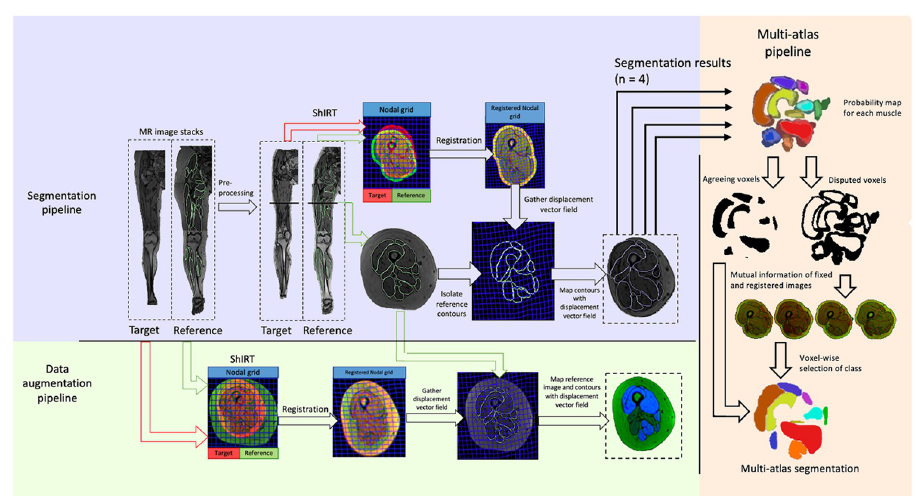
Fig 2. Registration, multi-atlas, and image augmentation pipelines. The image registration process, shown for one 2D slice of imaging data (location within imaging sequences highlighted with a black line). Segmentation pipeline: the target and reference subject were pre-processed, homogenizing the fat layer, and registered in ShIRT. The map found through registration was applied to the manual segmentation contours of the reference subject (shown in green), resulting in an automatic segmentation of the target subject (shown in blue). Data augmentation pipeline: The combined MR imaging sequences are registered in ShIRT. The map outputted from the registration was used to deform the reference subject’s 3D imaging data and reference manual segmentations, resulting in a fully segmented, augmented 3D image. The augmented images are shown with each muscle taking a different greyscale value (visualised in blue image channel). The multi-atlas pipeline used is also shown on the right-hand side. The outputs of the segmentation pipeline are combined forming a probability map for each muscle. The disputed and agreed voxels are separated, and the disputed voxels are labelled according to the best performing registration, found through calculating the mutual information of registered and fixed images. Collating these results provides a multi-atlas segmentation for each